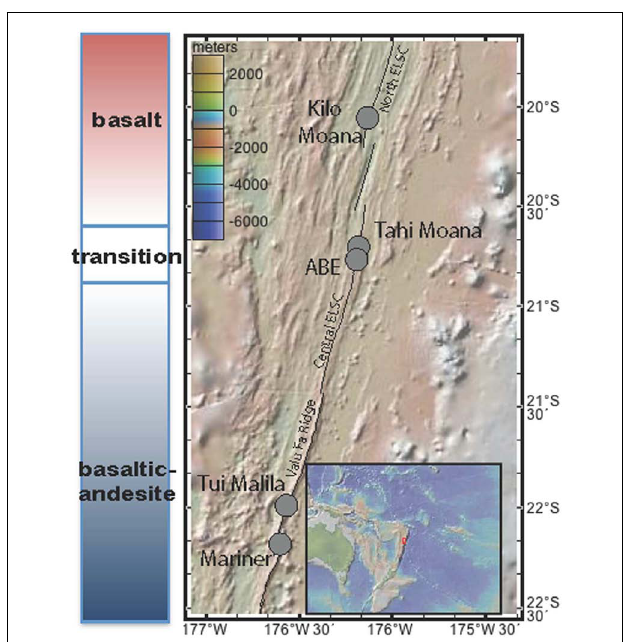
FIGURE 1 | Map of southern Lau Basin, with the Eastern Lau Spreading Center andValu Far Ridge. Samples were collected from Kilo Moana, ABE,Tui Malila, and Mariner vent